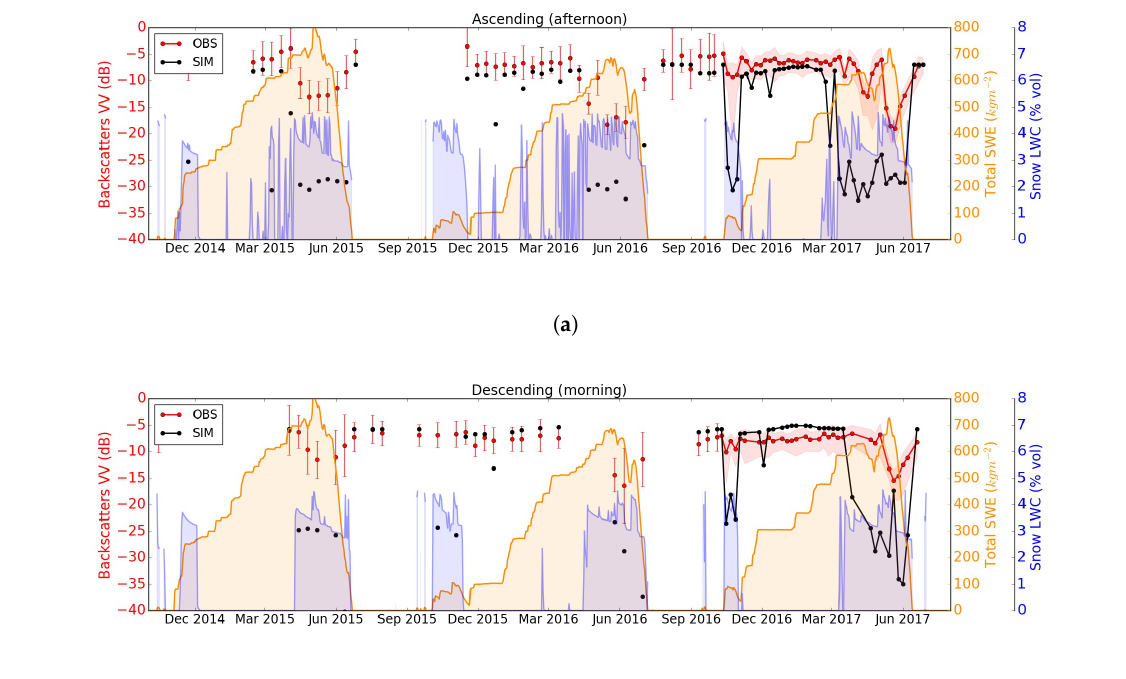
Figure 8. Time series of the backscatter along the three snow seasons for the 2900m area, using all simulations and observations scenes available in VV polarization. The maximum snow LWC across Crocus snow layers (blue) and the SWE (orange) are displayed for the corresponding SAFRAN-Crocus grid point: ( a ) ascending orbit; and ( b ) descending orbit. Error bars and shading represent one standard deviation around the mean of the observation values, shading being used when the time between two consecutive observations is less than six